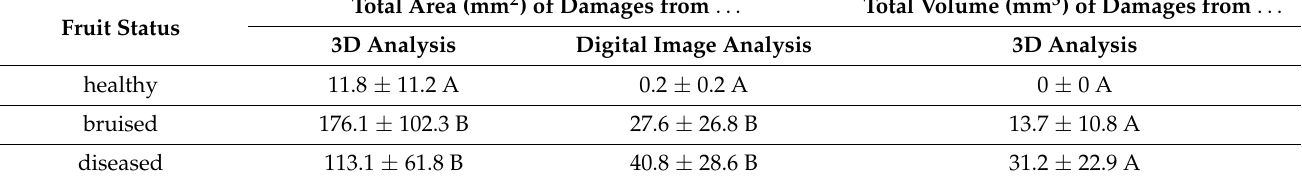
Table 7. Parameters calculated for characterization of the fruit bruising. Values shown are mean ± standard deviation. The same letter in the same column indicate no significant difference between fruit status (Duncan’s test, p < 0.05). Total Area (mm 2 ) of Damages from . . . Total Volume (mm 3 ) of Damages from . . Fruit Status